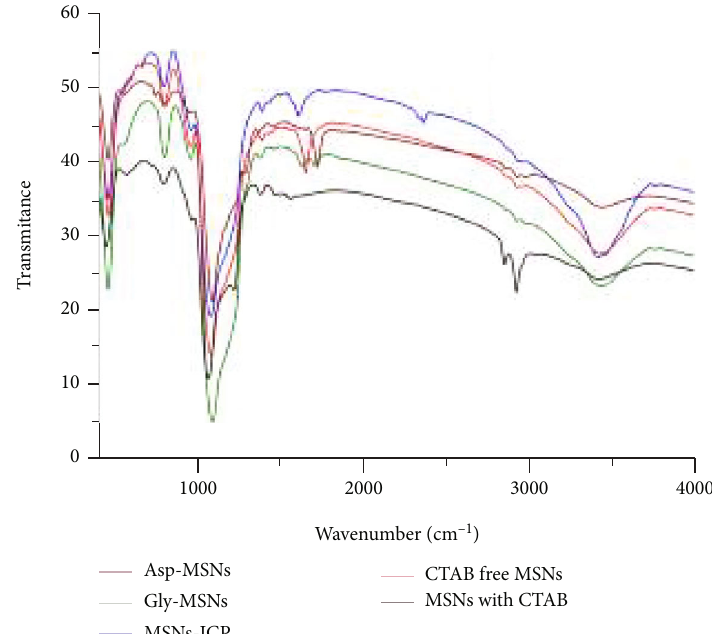
Figure 1: FTIR spectra of (black) MSNs (with CTAB), (red) CTAB free MSNs, (blue) MSNs-ICP, (brown) Asp-MSNs, and (green) Gly- MSNs.